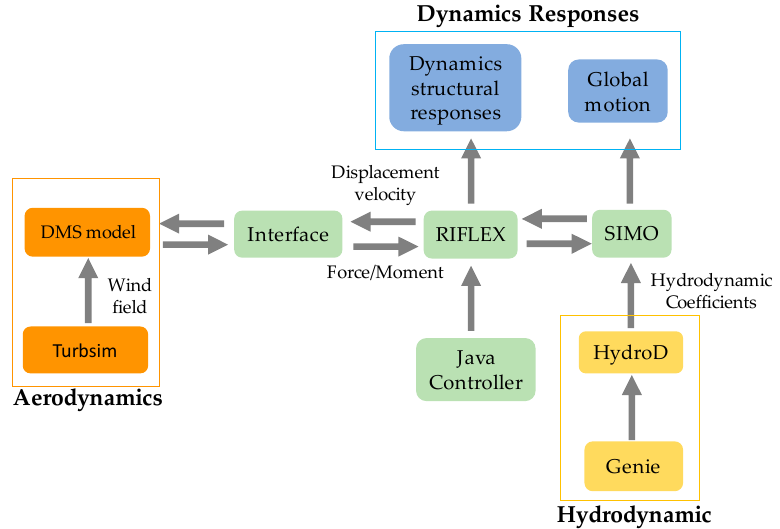
Figure 3. Computation flow chart for the coupled model (reproduced from Wang [9]).